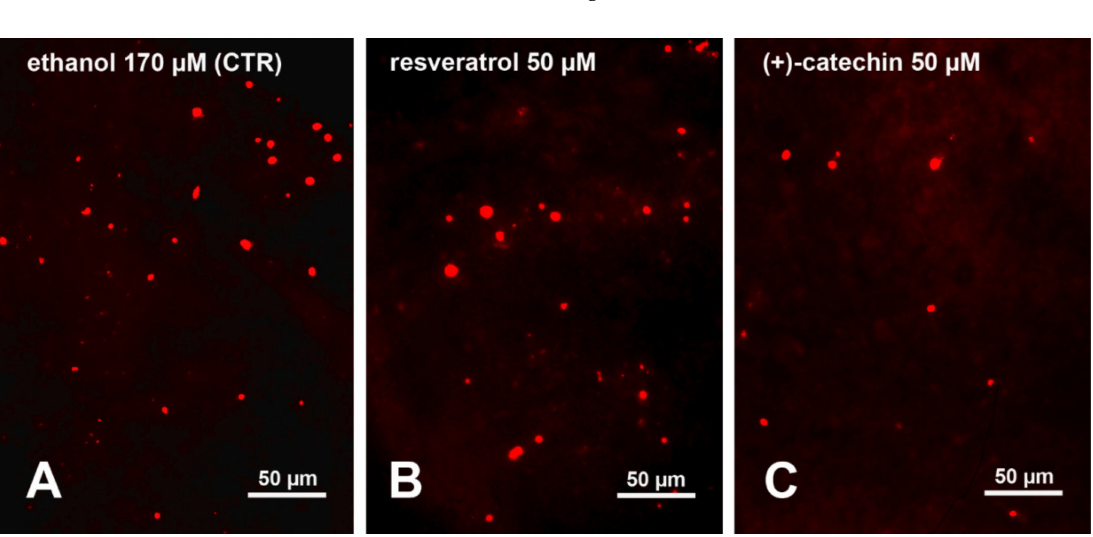
(# cells stained with PI / mm 2 ). Notably, the density of dead cells (mean ± 95% CI) raised from 17.56 ± 17.73 in plain medium, to 23.47 ± 8.76 (170 mM ethanol), 34.24 ± 2.30 (340 mM